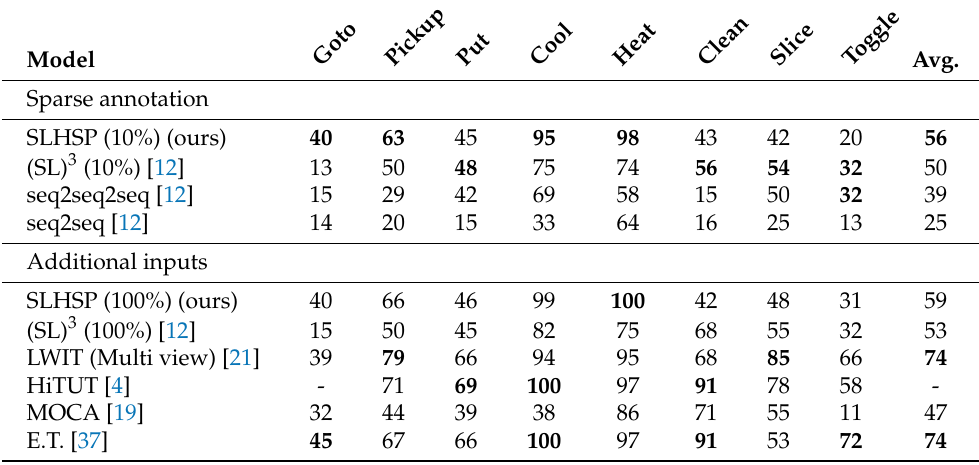
Table 3. Subgoal success rate v subtask on an unseen validation fold. The highest values per fold and subtask are shown in boldface. “-” denotes scores that are not